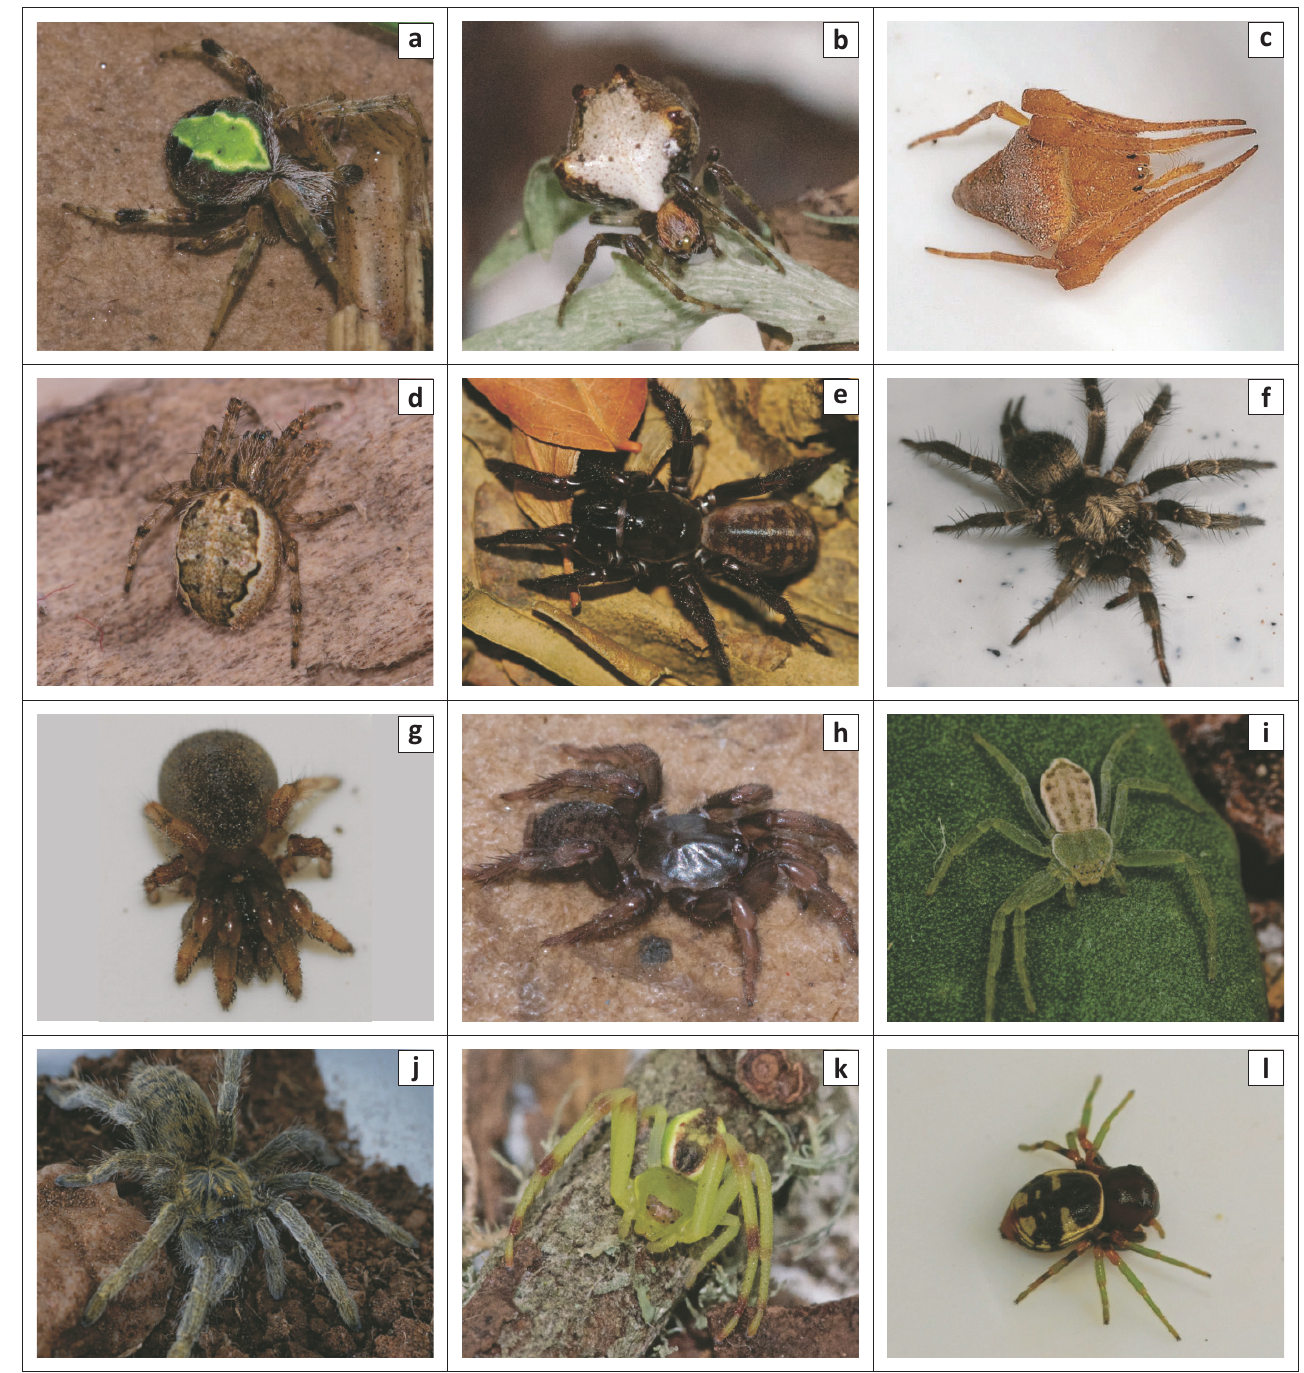
FIGURE 3: Selected spiders of the Addo Elephant National Park: (a) Araneus detrimentosus (O. Pickard-Cambridge, 1889) (Araneidae); (b) Undescribed Cyclosa sp. (Araneidae); (c) Ideocaira transversa Simon, 1903 (Araneidae); (d) Zygiella sp. (Araneidae); (e) Ancylotrypa cornuta Purcell, 1904 (Cyrtaucheniidae); (f) Allothele australis (Purcell, 1903) (Dipluridae); (g) Moggridgea rupicoloides Hewitt, 1914 (Migidae); (h) Hermacha grahami (Hewitt, 1915) (Nemesiidae); (i) New genus (Philodromidae); (j) Harpactirella magna Purcell, 1903 (Theraphosidae); (k) Diaea dorsata (Fabricius, 1777) (Thomisidae); (l) Mystaria lindaicapensis Lewis & Dippenaar-Schoeman, 2014